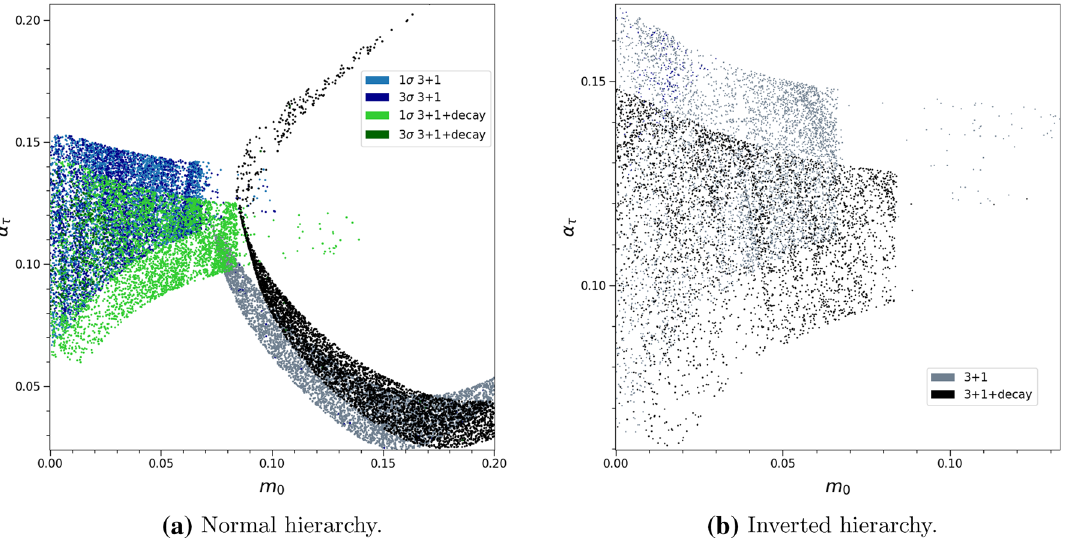
Fig. 3 Parameterspacefor α τ ,consistentwithneutrinooscillationdata,asafunctionofthelightestneutrinomass m 0 ,correspondingto α e ≈ 0 . 1910, α μ ≈ 0 . 1176 and θ ≈ 39 . 03 ◦ for the 3 + 1 scenario, and for the 3 + 1 + decay scenario as discussed in the text 12